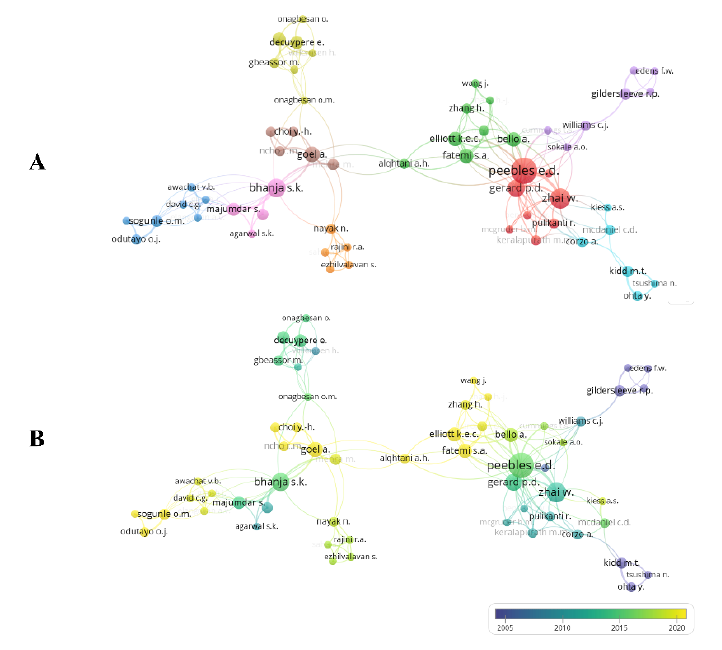
Figure 6. Authors network based on number of documents.